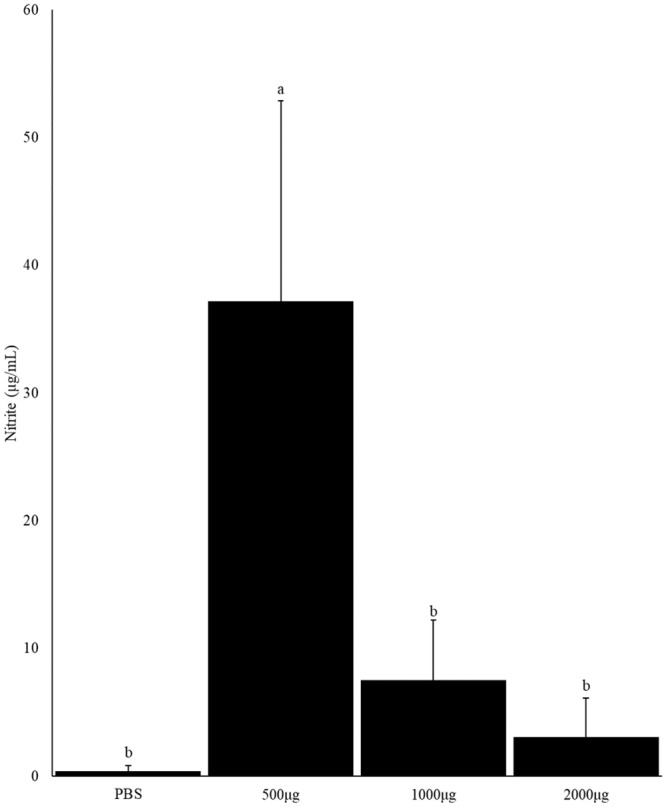
Effect of CNP–Salmonella vaccine on macrophage-nitrite production post-S. Enteritidis challenge.At 1d of age, chickens were orally vaccinated with either PBS (control-challenged) or different doses of outer membrane + flagellin proteins: 500μg, 1000 μg, or 2000 μg, loaded into CNP. The same route of delivery and doses was repeated at d7 of age. At d14 of age, birds were challenged with live S. Enteritidis (5.4 x 105 CFU/bird). Splenic macrophages were isolated from broilers at d25 (11d-post-challenge) of age and cells were stimulated with 1 μg/mL S. Enteritidis LPS. The nitrite content of the supernatant was determined using Griess assay. Results were reported as average optical density (OD) values. Bars (+SE) with no common superscript differ (P<0.05). n = 3 (Exp 1).